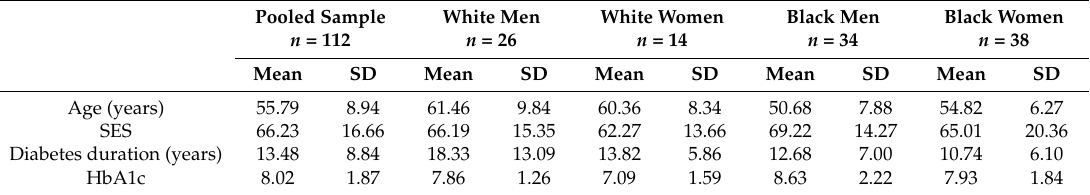
Table 1. Descriptive statistics for pooled sample and race by gender